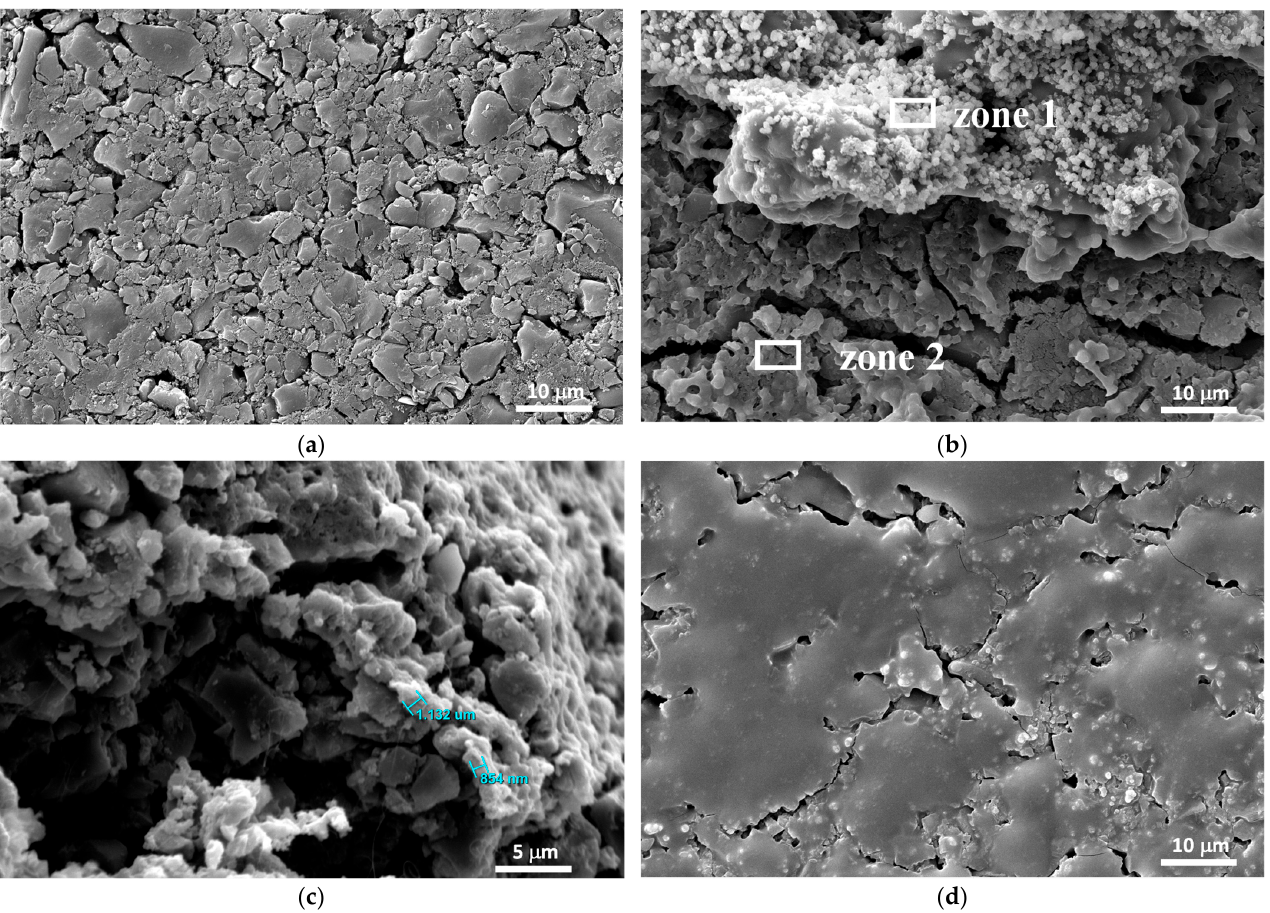
Figure 4. SEM images of ( a ) fresh AC electrode and the AC electrodes from the AC//Li half-cell charged to the high voltage of 10.0 V with different electrolytes; ( b , c ) PCE; ( d ) EPD. For the overcharged half-cell with EDD electrolytes, the gaseous products were col- lected and analyzed through a gas chromatograph, as shown in Figure 6a,b. It was identified that the emitted gas mainly consisted of H 2 , CO 2 , CH 4, and CO, and the relative volume ratio is 46.0%, 45.3%, 3.6%, and 5.1%, respectively. Other organic alkane gas is hardly found. The relative volume ratio between N 2 and O 2 is 3.0, which is near the composi- tion of air (78%:21%), and the two gas components are mainly ascribed to the mixed air during sampling. The gas evolution of CO 2 is attributed to the oxidative decomposition of solvent on the AC electrode surface. CO, CH 4, and H 2 gas are mainly ascribed to the reductive decomposition of solvent and trace amount of H 2 O/HF on metallic Li electrode surface [27–29]. Since the linear solvents, e.g., dimethyl carbonate (DMC), are more prone to degradation than those of cyclic solvents of ethylene carbonate (EC) and propylene carbonate (PC) [30], the decomposition of DMC is taken as an example, and the possible reactions are as follows